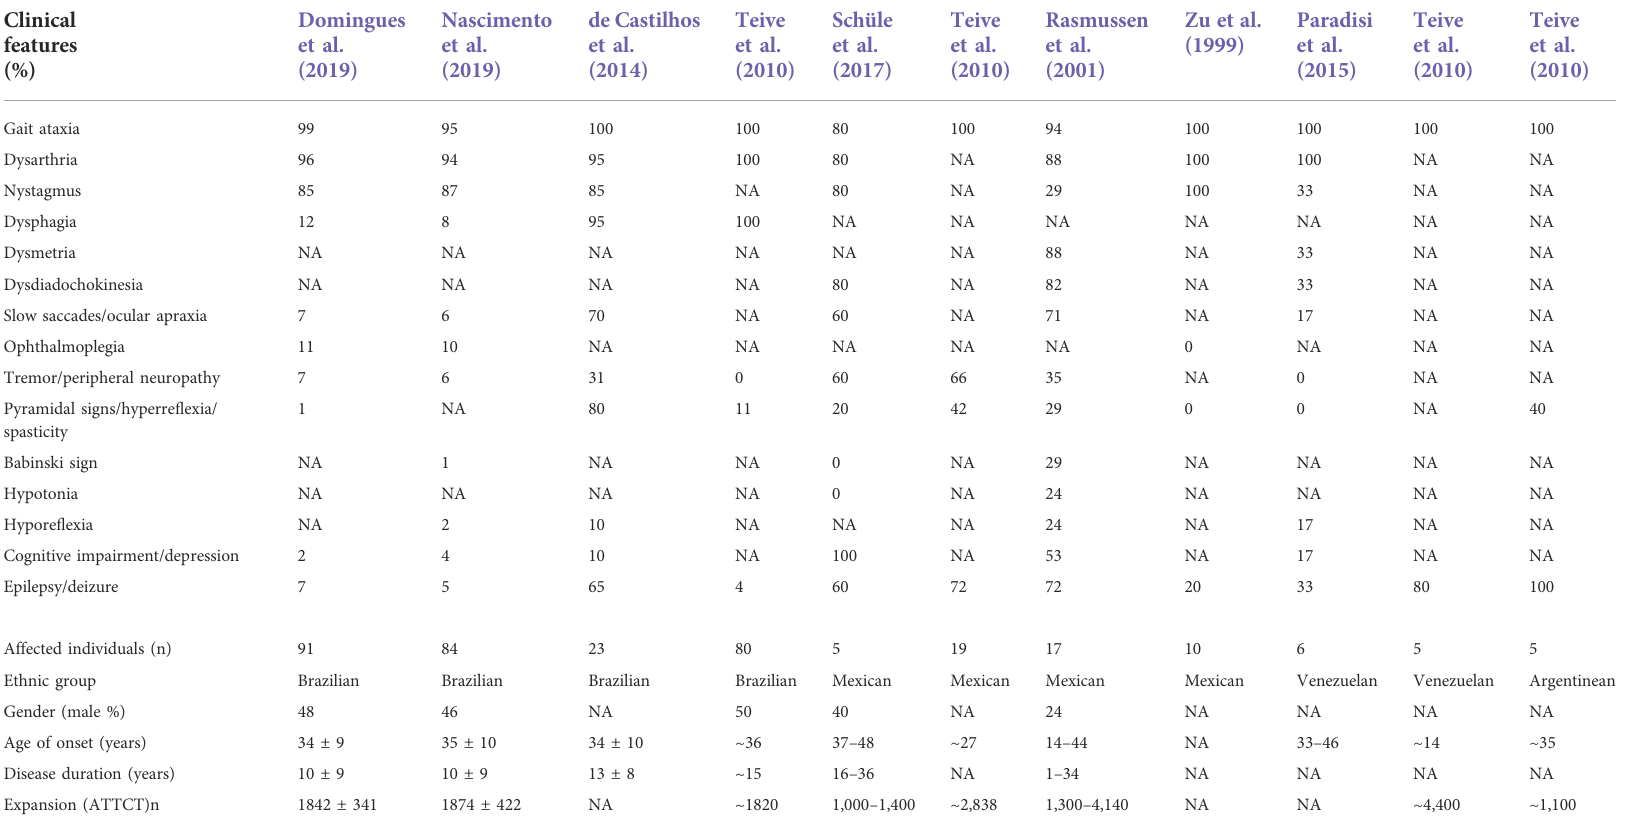
TABLE 2 The clinical features of